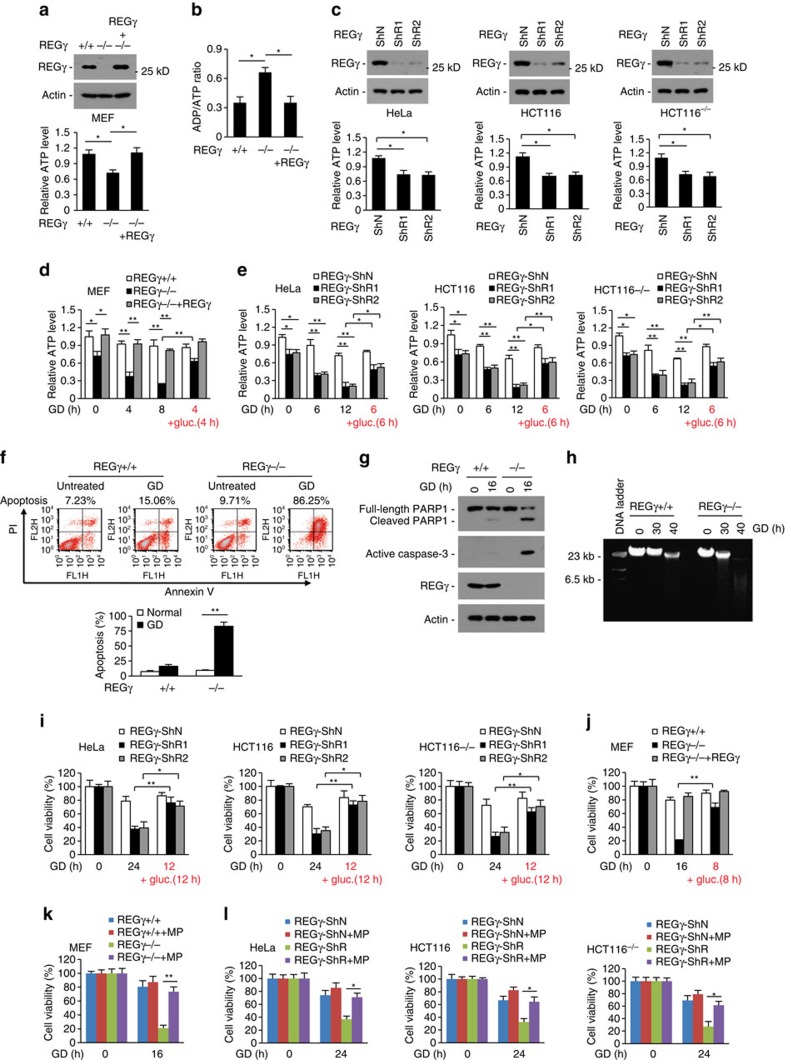
REGγ deficiency promotes energy consumption and starvation-induced cell death.(a–c) REGγ regulates cellular energy homeostasis under normal growth conditions. (A,B) MEF cells from wild-type (+/+, WT) and REGγ knockout (−/−, KO) mice were cultured in DMEM-high glucose medium. The relative intracellular ATP levels (a) and the cellular ADP/ATP ratios (b) were detected. To determine the specific effect of REGγ, REGγ-KO MEF cells were infected with lentiviral vectors expressing REGγ. Western blots show REGγ expression. (c) The relative intracellular ATP levels in HeLa, HCT116 and HCT116−/− (p53 null) cancer cells with stable knockdown of REGγ (ShR1 or ShR2) or a vector control (ShN) cultured in DMEM-high glucose medium. Western blots show the knockdown efficiency. (d,e) REGγ deficiency promotes energy consumption. Indicated cell lines were cultured in glucose-free DMEM (glucose deprivation, GD) for the indicated time periods, or re-supplemented with glucose (+gluc.) for 4 or 6 h after GD. The relative intracellular ATP levels were analysed. (f-l) REGγ deficiency promotes energy-dependent cell death. (f) REGγ-WT and -KO MEF cells were treated with GD for 16 h and apoptosis was analysed by FACS. Quantitative data show percentage of apoptosis. (g) REGγ-WT and -KO MEF cells were treated with GD for 16 h and analysed for activated caspase-3 and poly (ADP-ribose) polymerase cleavage by western blotting. (h) REGγ-WT and -KO MEF cells were treated with GD for the indicated times and the large-scale DNA fragmentation was determined by agarose gel electrophoresis. (i,j) Indicated cell lines were treated with GD, or re-supplemented with glucose (+ gluc.) for the indicated time periods after GD. Cell viability was determined using MTT assay. (k,l) Indicated cells were treated with GD in the presence or absence of methyl pyruvate (MP, 10 μM) for the indicated time periods, and cell viability was analysed using MTT assay. All experiments were repeated three times, data represent mean±s.d., *P<0.05, **P<0.01; Student's t-test is used throughout. See also Supplementary Fig. 1.